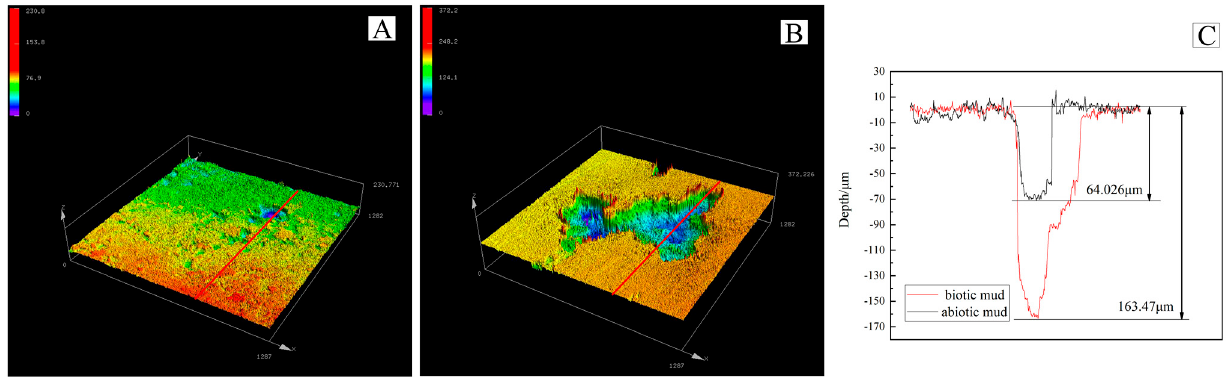
Figure 5. CLSM images of coupons immersed in different conditions for 14 days after removal of the surface products. ( A ) abiotic mud, ( B ) biotic mud, ( C ) comparison chart of maximum pit depth.